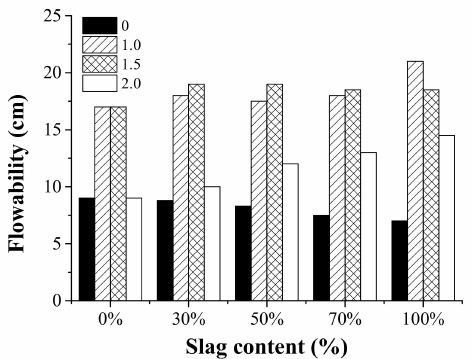
Figure 5. The e ff ect of the activator modulus (0, 1.0, 1.5, 2.0) and the slag content (0%, 30%, 50%, 70%, and 100%) on the spread diameter (flowability) of the AAFS